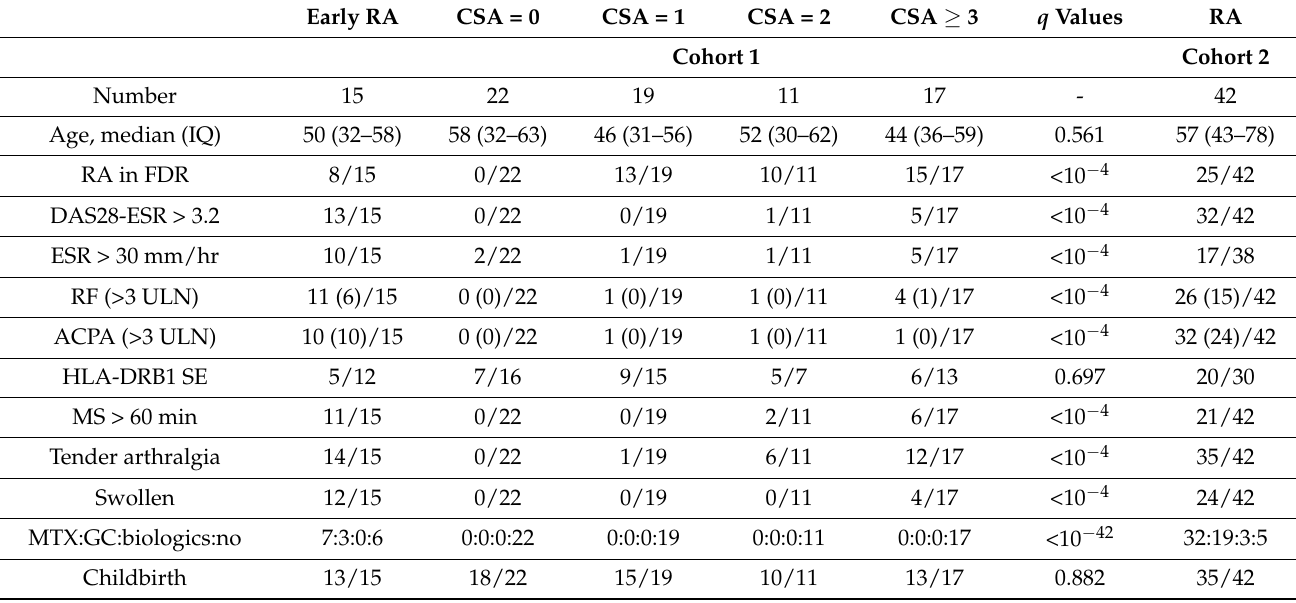
Table 2. Studied population